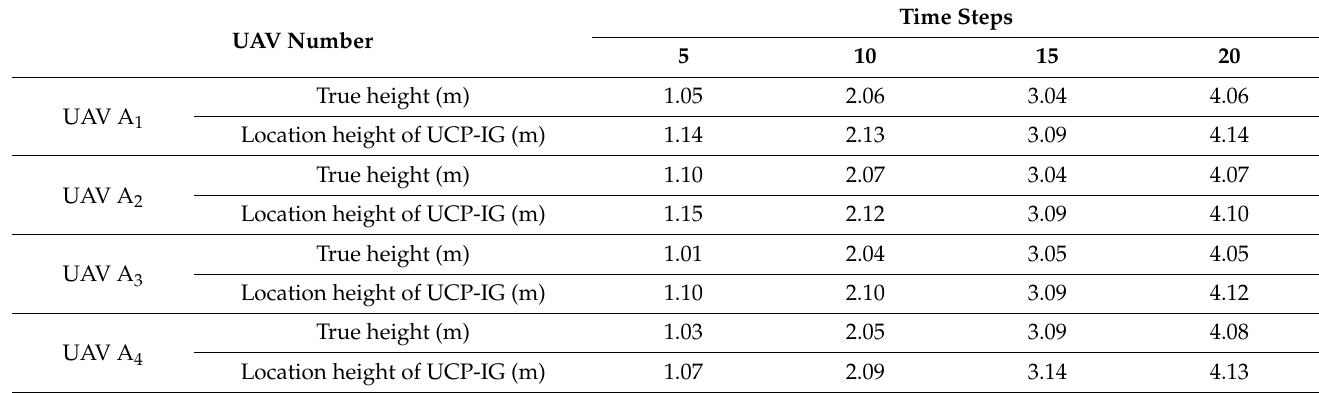
Figure 13. GUI positioning error display platform (experimental occlusion scenario). Table 6. Part of the experimental data (experimental random